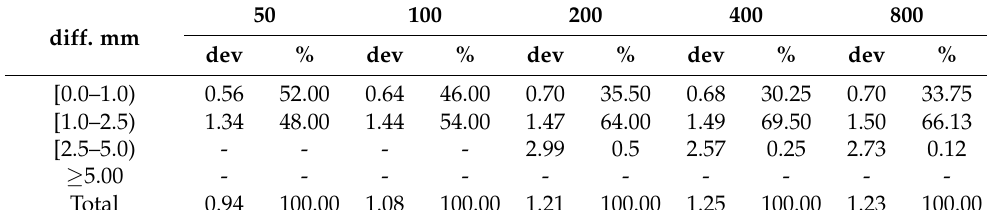
Table 1. Comparison of semilandmarks from sliding TPS and TPS&NICP approaches. Table 2. Comparison of semilandmarks from sliding TPS and LS&ICP approaches.